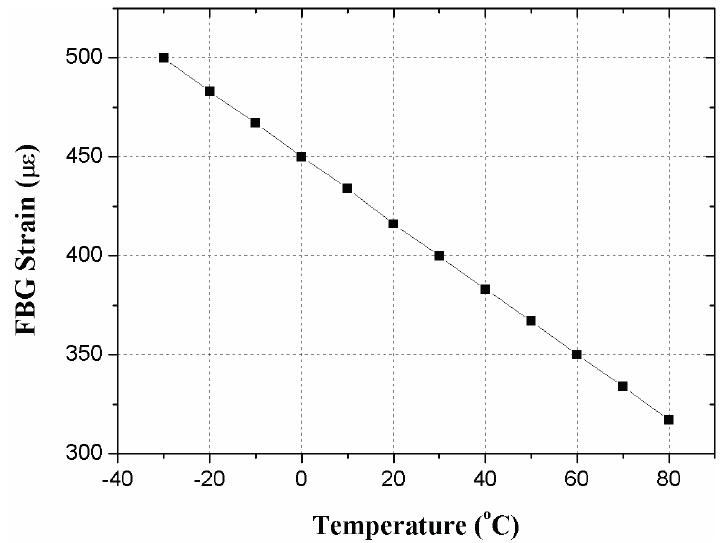
Figure 7. Theoretical FBG strain as a function of temperature with the same